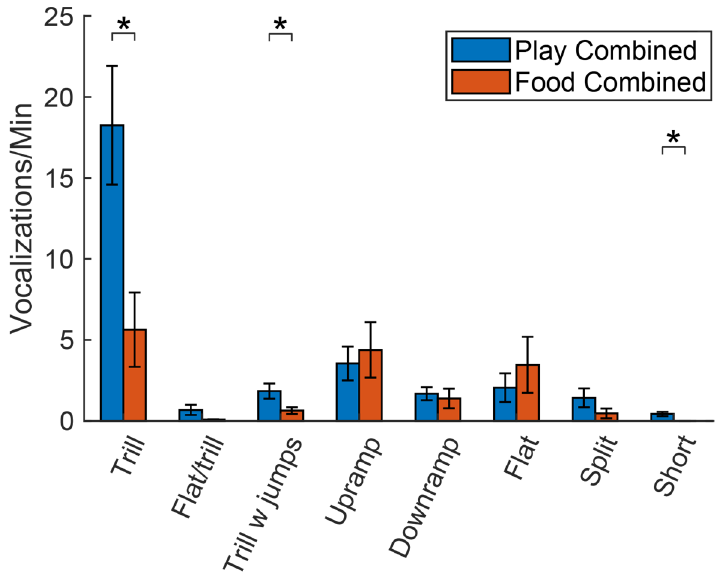
Figure 4. Comparison of the rates of calls on day 1 for all food and play groups. Play includes both Play Reward and Play Control while food includes both Food Reward and Food Control. Asterisks denote comparisons that were statistically significant ( p < 0.05).